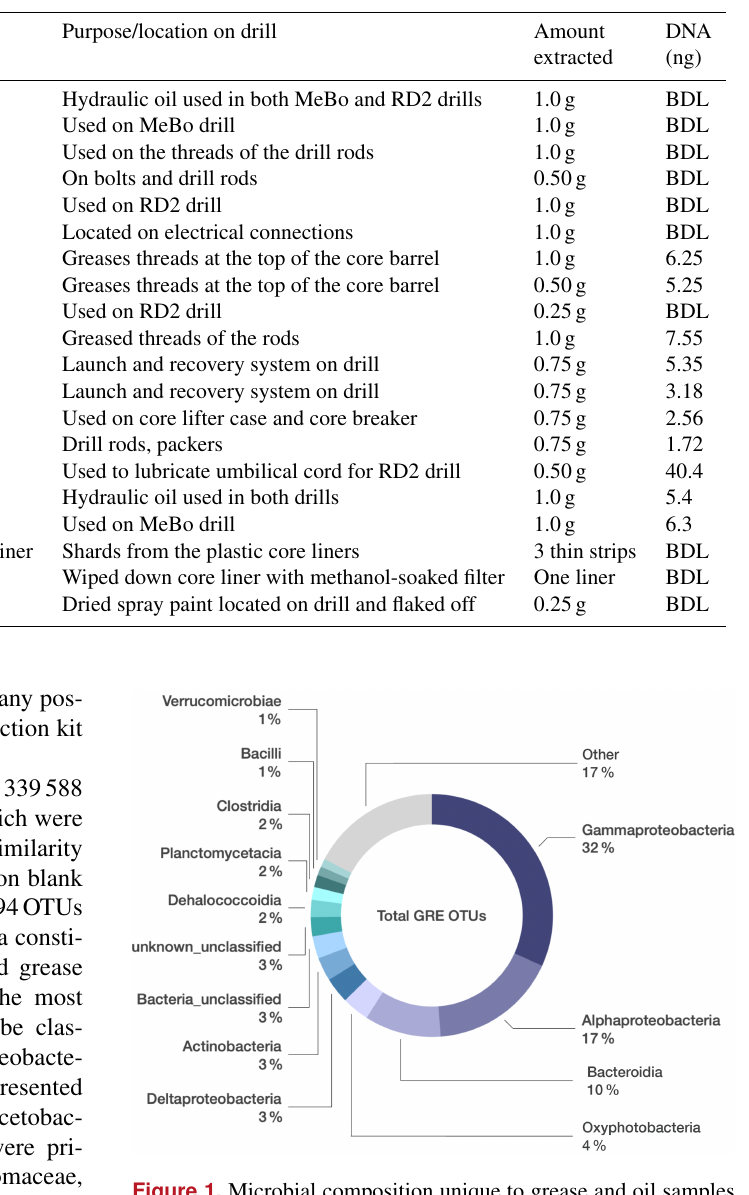
Table 2. Description and DNA concentration of drill-associated samples. Twenty samples were taken during the duration of the cruise, in- cluding grease, oil, plastic shards, spray paint, and a cotton filter liner. Total DNA (ng) values represent measurements post DNA purification.